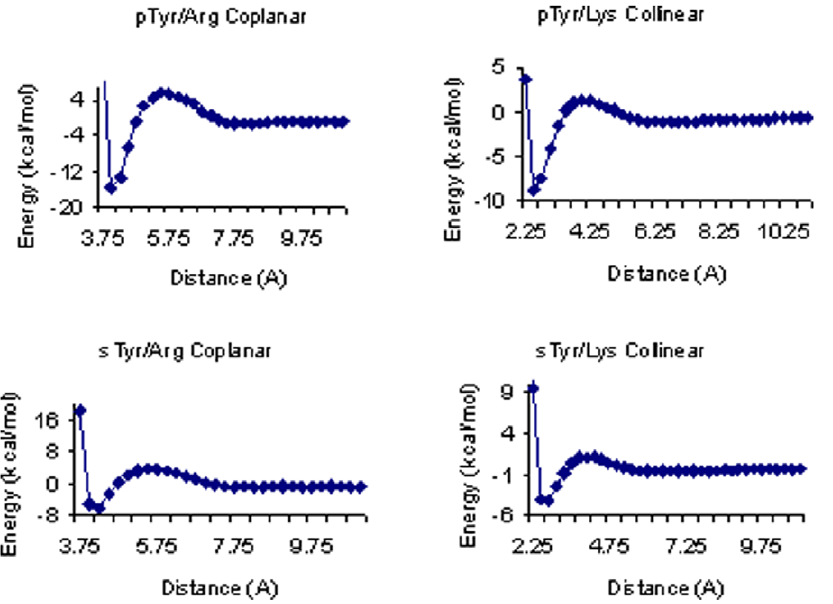
Figure 1. Implicit Solvent Potentials of Mean Force for representative residue pairs. Plots show interaction energy vs. distance, at distance intervals of 0.25 A˚, for a pair of residues in a given orientation. Distance refers to the P-C distance between the phosphate atom and the terminal carbon on Arg (coplanar), or the N-O distance (collinear).